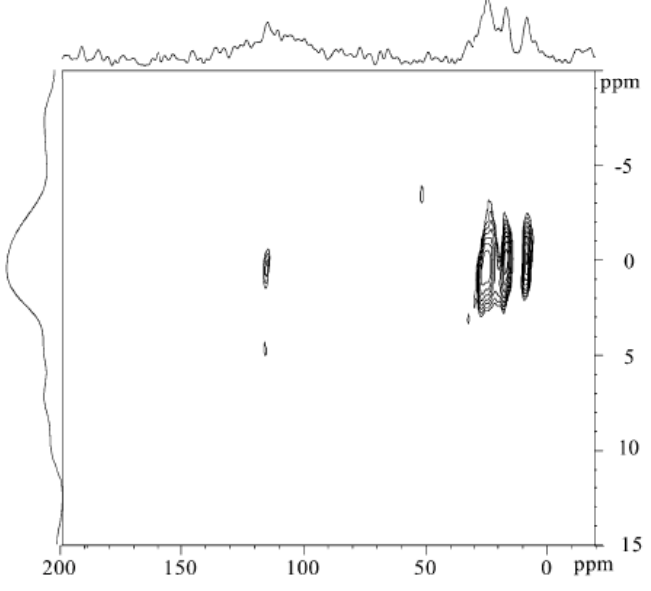
Figure 5. 1 H– 13 C 2D correlation spectra of functionalized carbon nanotubes. Reprinted from reference [56] with permission from the American Chemical Society.